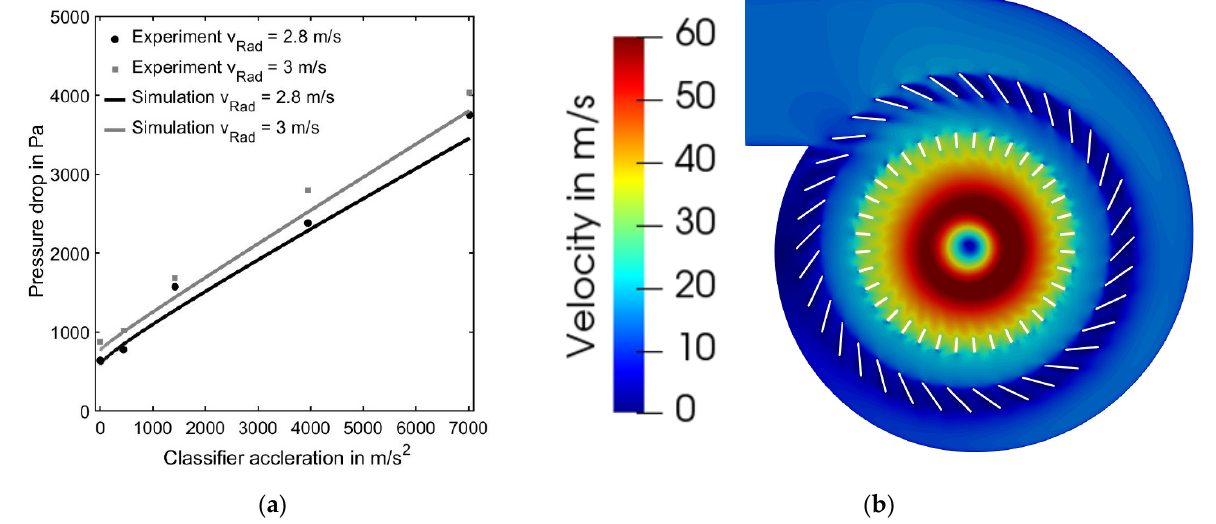
Figure 3. ( a ) A comparison of the calculated and measured pressure loss for different operating conditions; ( b ) the velocity profile in the